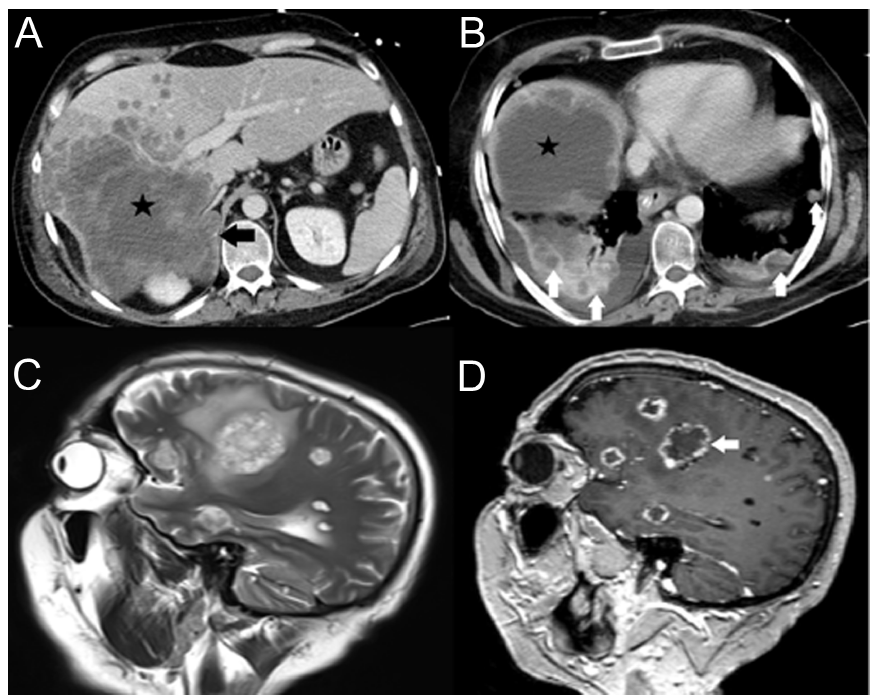
Figure 5. A-D. Axial contrast-enhanced computed tomography (CT) imaged at the level of the liver (A) and lung basis (B) shows alveolar echinococcosis lesion in the liver (black stars in A and B) and lung (white arrows in B). In addition to the liver lesion, sagittal T2-weighted magnetic resonance (MR) image (C) and sagittal T1-weighted contrast-enhanced image (D) show multiple alveolar echinococcosis metastases in the brain. The lesion in the liver appears to invade the right adrenal gland with local invasion (black arrow in A). Note that metastases observed in the brain show peripheral contrast enhancement (white arrow in D) and vasogenic edema effect is observed around the lesions on sagittal T2-weighted MR